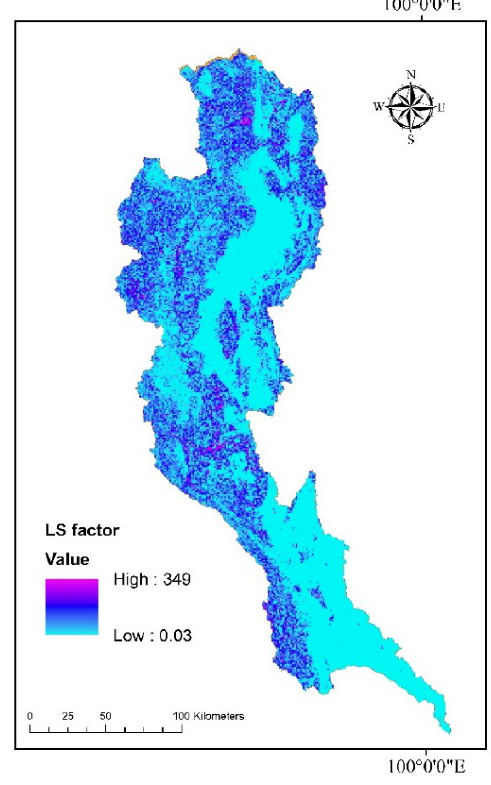
Figure 5. Erodibility factor map.